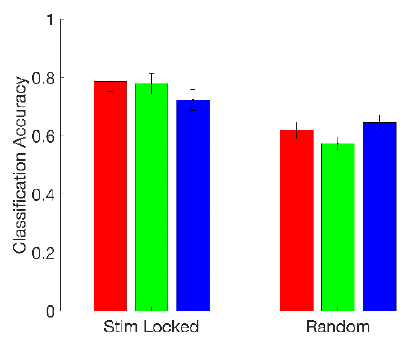
Figure 7. Fused-feature classification mean accuracy across subjects for logistic regression (red), quadratic discriminant analysis (green), and 3-NN (blue), when 1-s feature extraction windows were triggered by the onset of the color–word stimulus (“Stim Locked”) and when 1-s feature extraction windows were taken at random times (“Random”). Error bars are two standard errors in length.